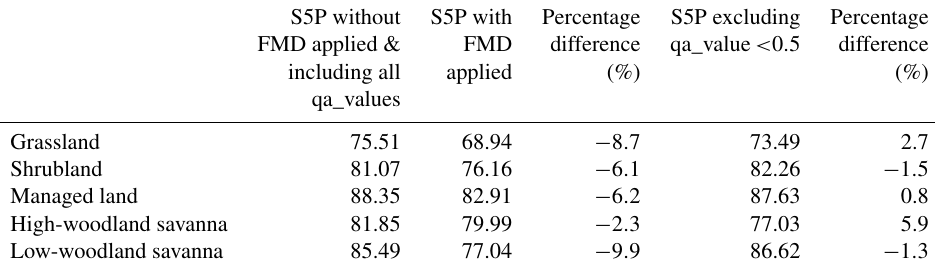
Table A1. Comparison of smoke emission coefficients generated from standard S5P data (which has neither the FMD procedure applied or a qa_value threshold of > 0 . 5 applied) and those generated from S5P with both these adjustments applied. Percentage differences between the standard S5P data and these two variants of the S5P data are also